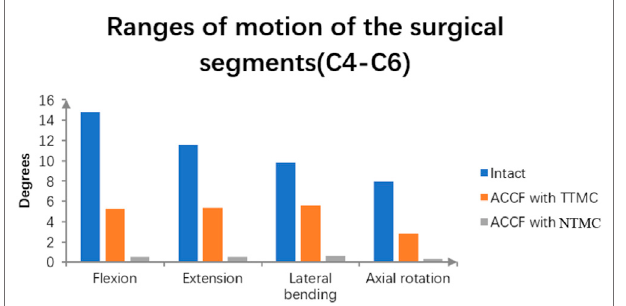
FIGURE 5 | Using the intact model as a reference, comparisons of the ROMs of the surgical segments (C4 – C6) between the TTMC and NTMC models has been performed.